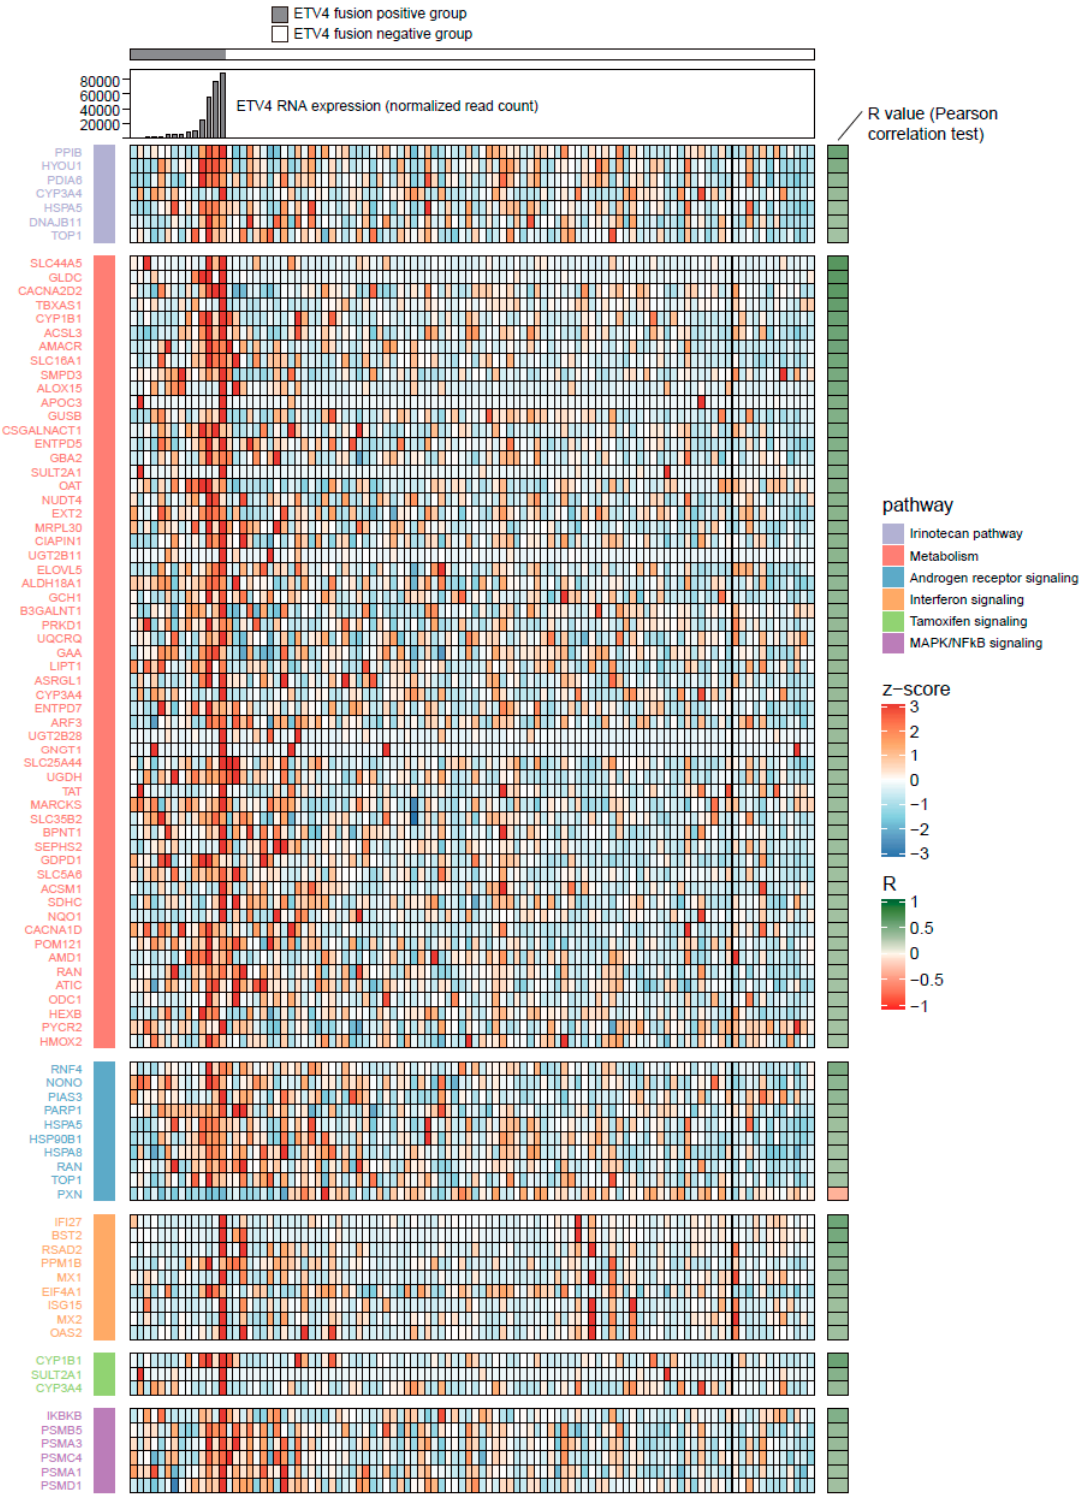
Figure 1. RNA expression heatmap of six cancer-specific pathways. RNA expression was converted into z-scores. Rows include each gene of the cancer-specific pathways arrayed by each pathway. Columns include each sample of an ETV4 -fusion-positive or -negative